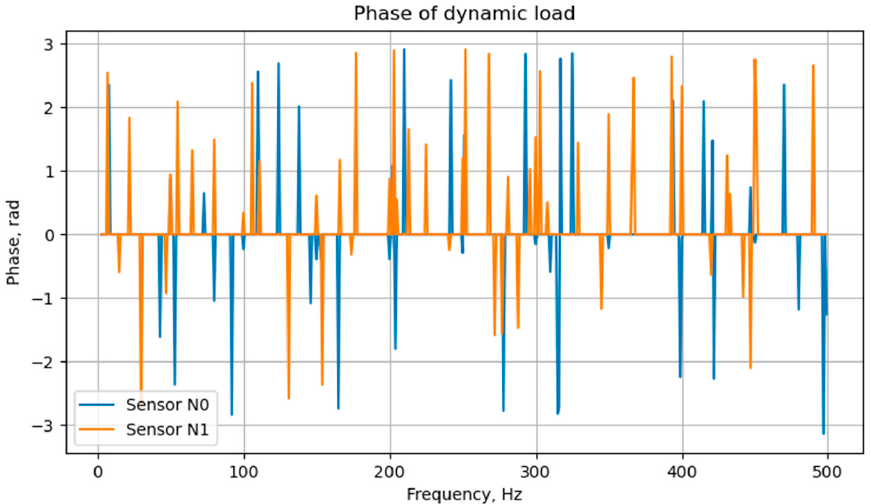
Figure 8. Spectrum of the simulated signal coming to two sensors.